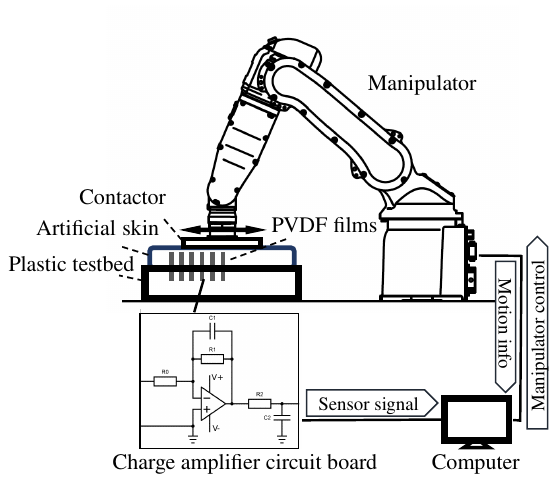
Figure 9. Experimental